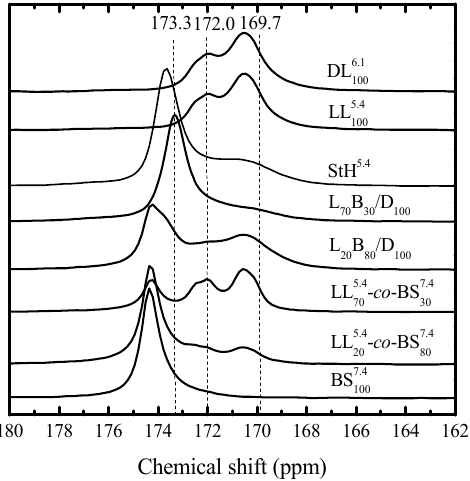
Figure 11. Proton-decoupled 13 C spectrum of homopolymers, copolymers, and mixtures thereof to form PLA stereocomplexes (400 MHz).